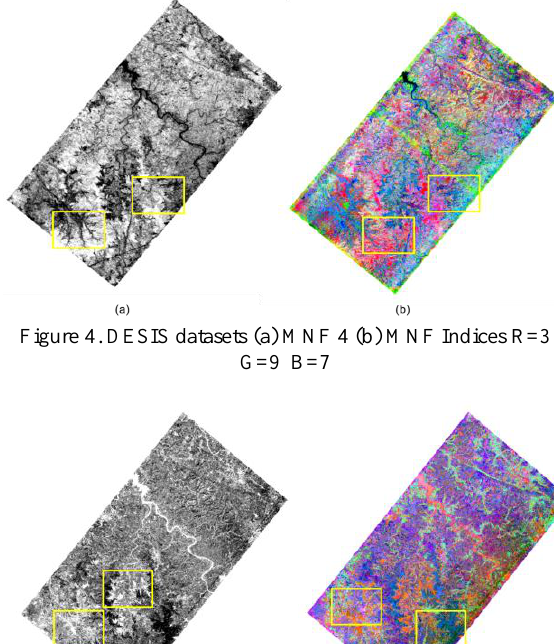
Figure 2. Lithological Map for the Study area